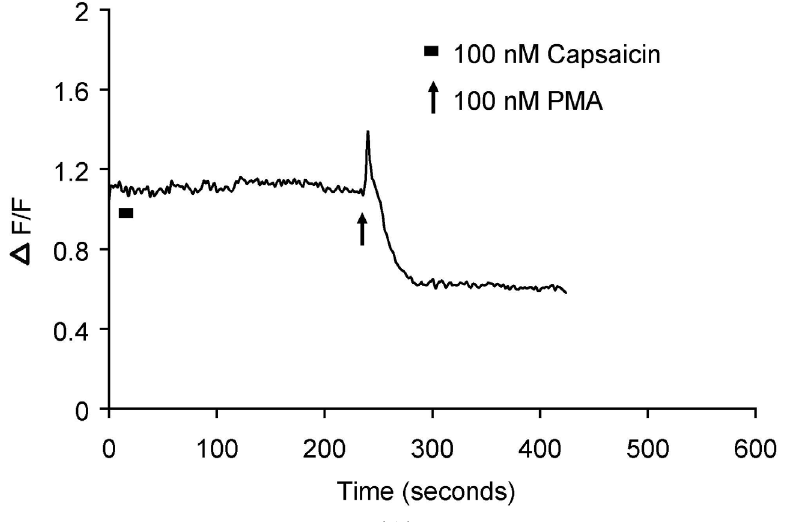
Figure 2. Translocation kinetics of PKC β II-EGFP in a single cell body of capsaicin-insensitive DRG